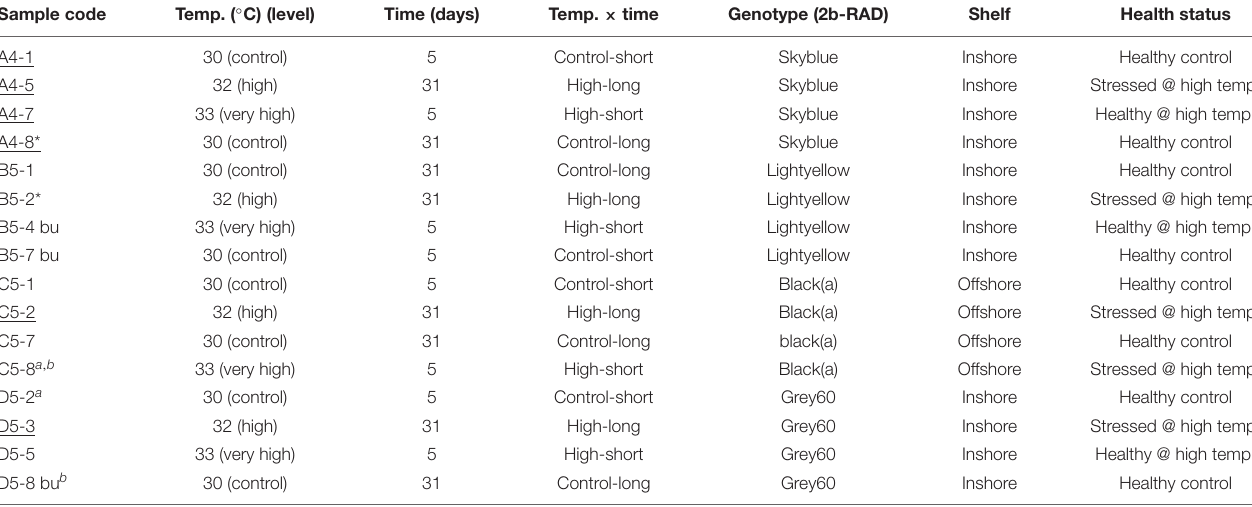
TABLE 1 | Orbicella faveolata samples analyzed by shotgun proteomics. Sample